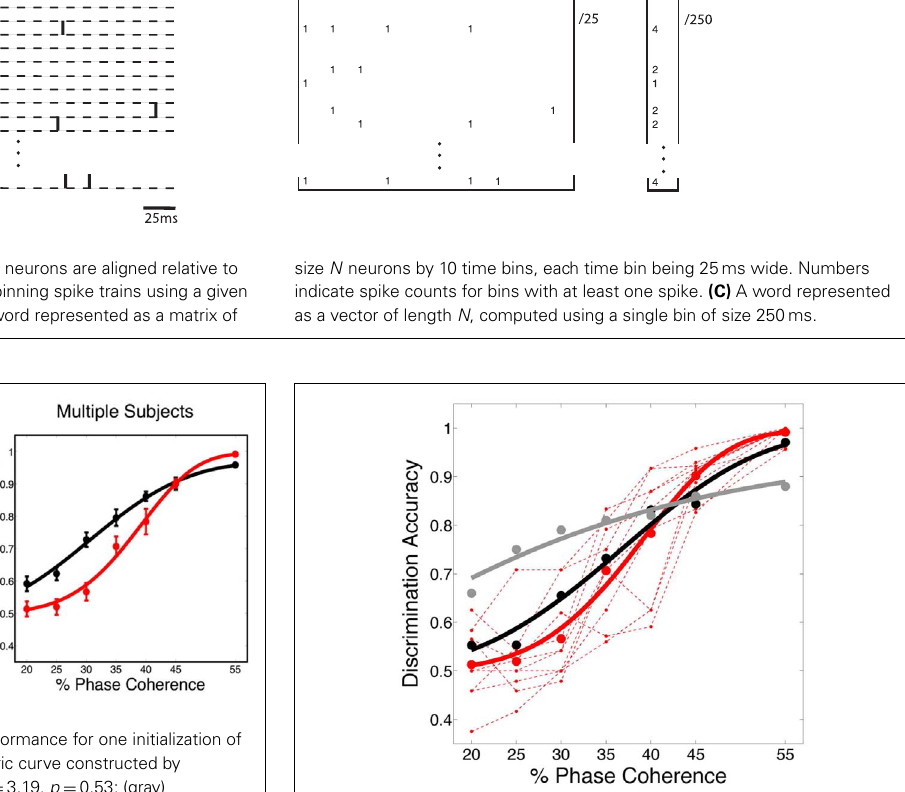
ALTERNATIVE DECODING